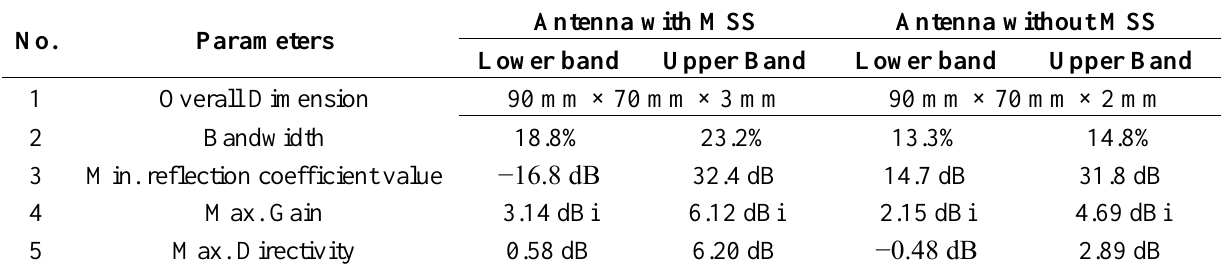
Table 2. Performance specifications of the proposed antenna with and without MSS.